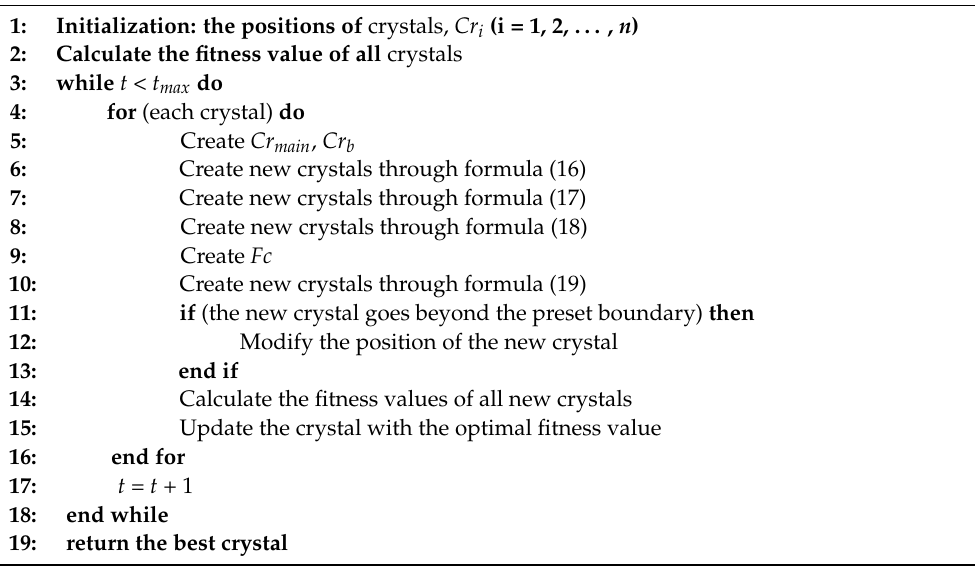
Algorithm 2. Pseudo-code of